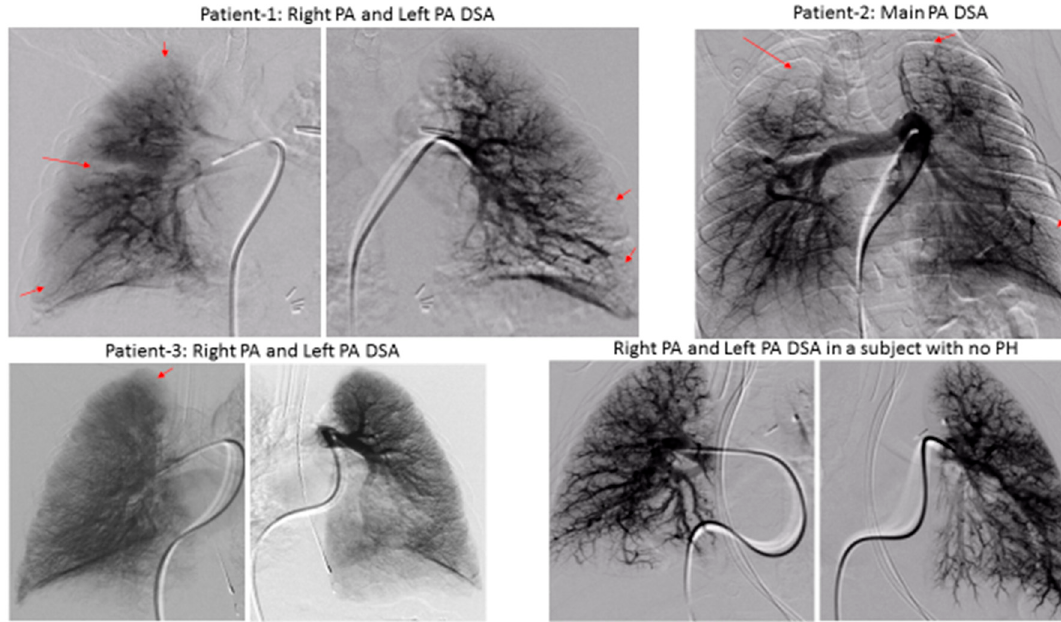
Figure 2. Digital Subtraction Pulmonary Angiography showing segmental perfusion defects (capillary phase, pointed by arrows) in three patients versus a normal subject with no pulmonary hypertension. (PA: pulmonary artery, DSA: digital subtraction angiography, PH: pulmonary hypertension).